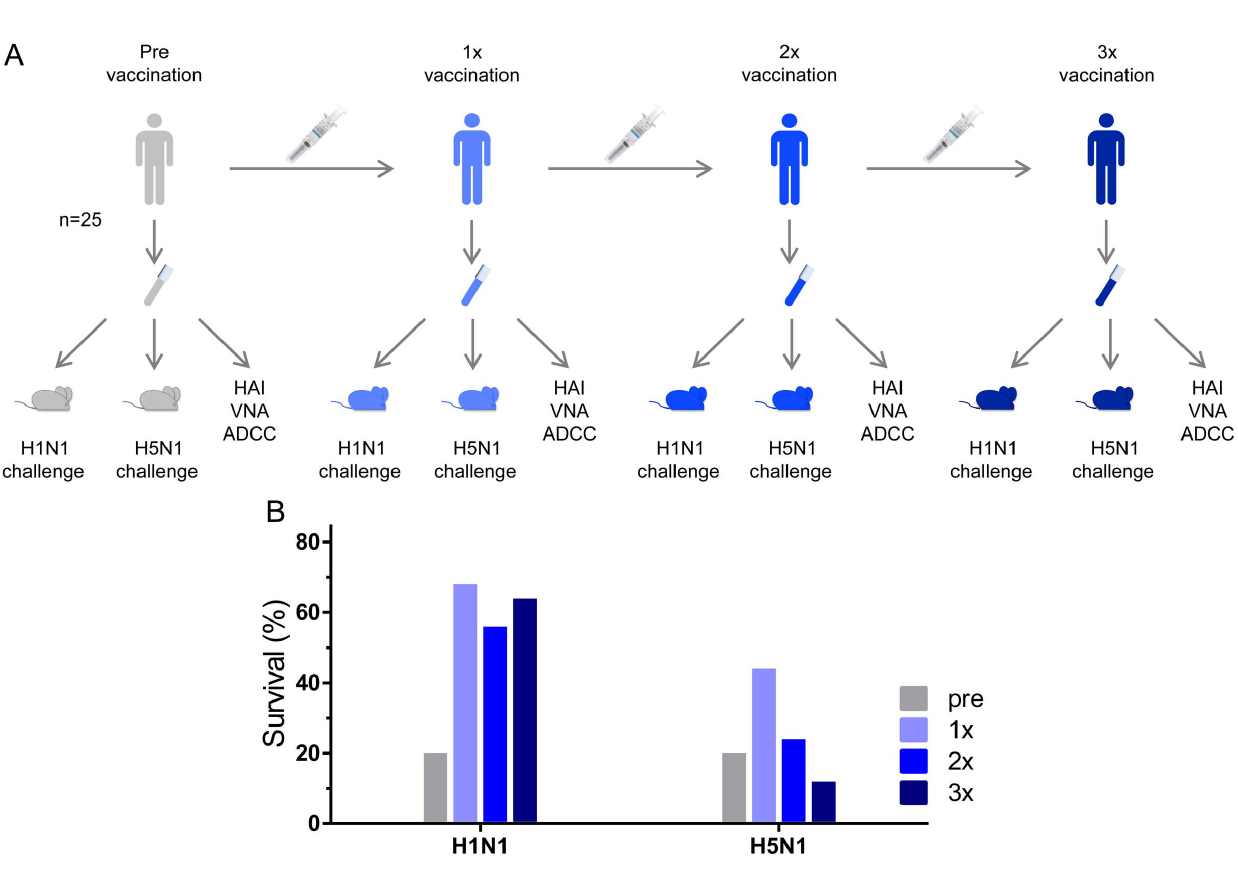
Figure 6. Heterosubtypic protection by post-vaccination serum is not boosted by subsequent immunizations and is lost after the second vaccination. ( A ) Serum was obtained from 25 human subjects immediately prior to the first vaccination and 4 weeks after each of three vaccinations (pre-vaccination, 1 6 , 2 6 , and 3 6 , respectively). ( B ) Human-to-mouse serum transfer was used to assess humoral protection against vaccine homologous H1N1 A/Netherlands/602/2009 and heterosubtypic H5N1 A/Hong Kong/156/97 influenza viruses. To assess the protective activity of the sera, 400 m l of each serum sample was transferred to each of two individual mice which were challenged 24 h later with 25 6 LD 50 of vaccine homologous A/Netherlands/602/2009 (H1N1) or heterosubtypic A/Hong Kong/156/97 (H5N1), respectively. All post-vaccination groups show comparable protection against H1N1 challenge. There is a significant difference in protection against H5N1 among different vaccination groups (exact logistic regression,